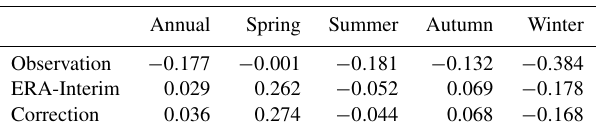
Table 10. Trends ( ◦ C10a − 1 ) of annual and seasonal DTR over the 24 sites in